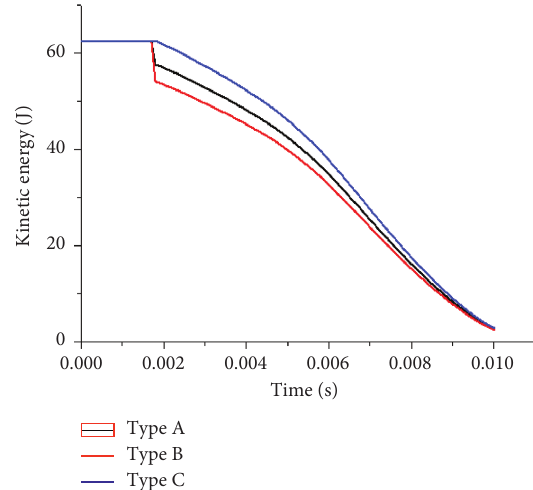
Figure 8: Impact kinetic energy-time history of the rigid